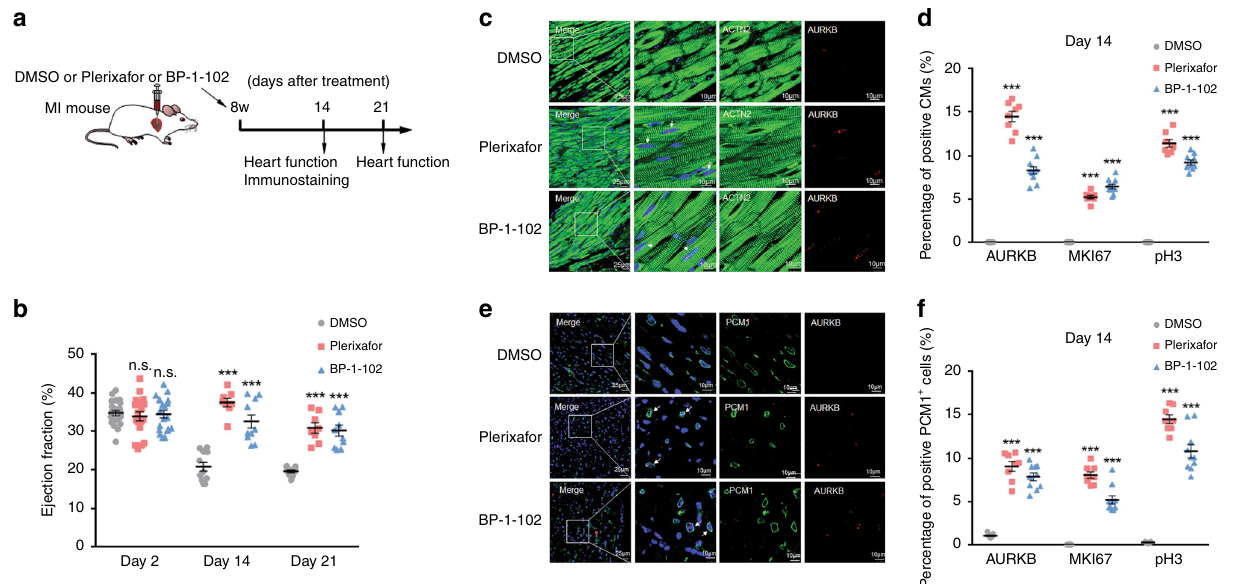
Fig. 8 Pathway inhibition reverses CM maturation upon injury. a Work fl ow of animal experiment. Eight-week-old mice were subjected to myocardial infarction (MI) surgery, and corresponding inhibitors or DMSO were administered immediately afterwards. Mice were sacri fi ced 14 days post surgery, and hearts were removed for immunostaining. The additional set of mice was monitored for cardiac function on days 2, 14, and 21. b Quanti fi cation of ejection fraction based on echocardiogram. Data are plotted as mean ± SEM, n = 23, 18, 20 biologically independent mice in DMSO, Plerixafor and BP-1-102 group at Day 2, respectively, n = 11, 8, 10 biologically independent mice in DMSO, Plerixafor and BP-1-102 group at Day 14 and Day 21, respectively. *** p < 0.001, n.s. not signi fi cant, two-way ANOVA. c Immuno fl uorescent staining against ACTN2 and AURKB in the border zones of infarcts from (a). White arrows indicate co-localized cells. Scale bars = 10 or 25 μ m. d Quanti fi cation of ACTN2 + AURKB + and ACTN2 + MKI67 + , and ACTN2 + pH3 + cells . Data are plotted as mean ± SEM, n = 11, 8, 10 biologically independent mice in DMSO, Plerixafor and BP-1-102 group, respectively. *** p < 0.001, one-way ANOVA. e Immuno fl uorescent staining against PCM1 and AURKB in the border zones of infarcts from a . White arrows indicate co-localized cells. Scale bars = 10 or 25 μ m. f Quanti fi cation of PCM1 + AURKB + and PCM1 + MKI67 + , and PCM1 + pH3 + cells . Data are plotted as mean ± SEM, n = 11, 8, 10 biologically independent mice in DMSO, Plerixafor and BP-1-102 group, respectively. *** p < 0.001, one-way ANOVA. Source data are provided as a Source Data fi